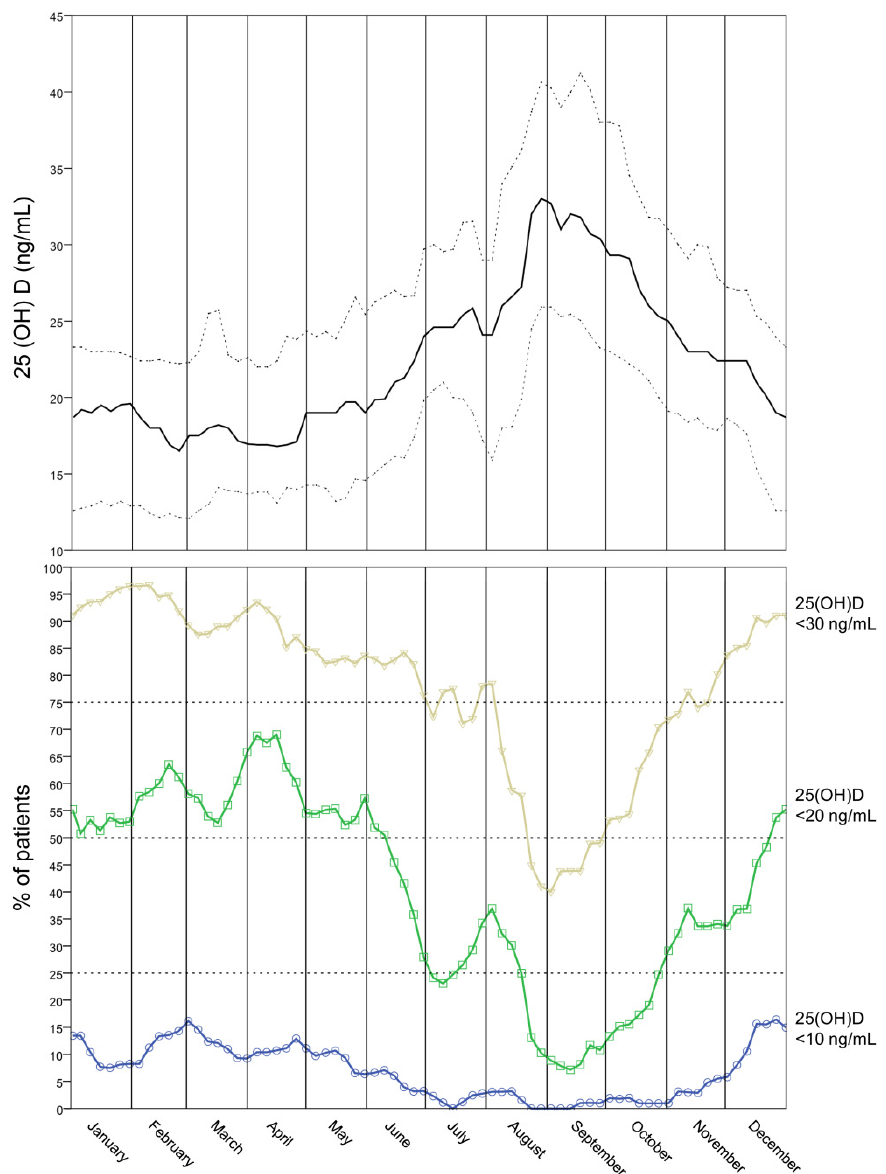
Figure 1. Annual serum 25(OH)D levels. Upper panel shows the moving median for annual serum 25(OH)D concentration for the entire cohort of women. Lower and upper dotted lines represent 25th and 75th percentiles, respectively. Lower panel graphically depicts the relative proportion of patients with serum 25(OH)D concentrations below the threshold values of 30 ng/mL (yellow open triangles), 20 ng/mL (green open squares) and 10 ng/mL (blue open circles) as a function of the monthly period. Table 2. Prevalence of serum 25(OH)D concentration below the threshold values of 10 ng/mL, 20 ng/mL and 30 ng/mL and according to the four trimesters. The first trimester was used as a reference group for odds ratio calculation. CI, confidence interval.